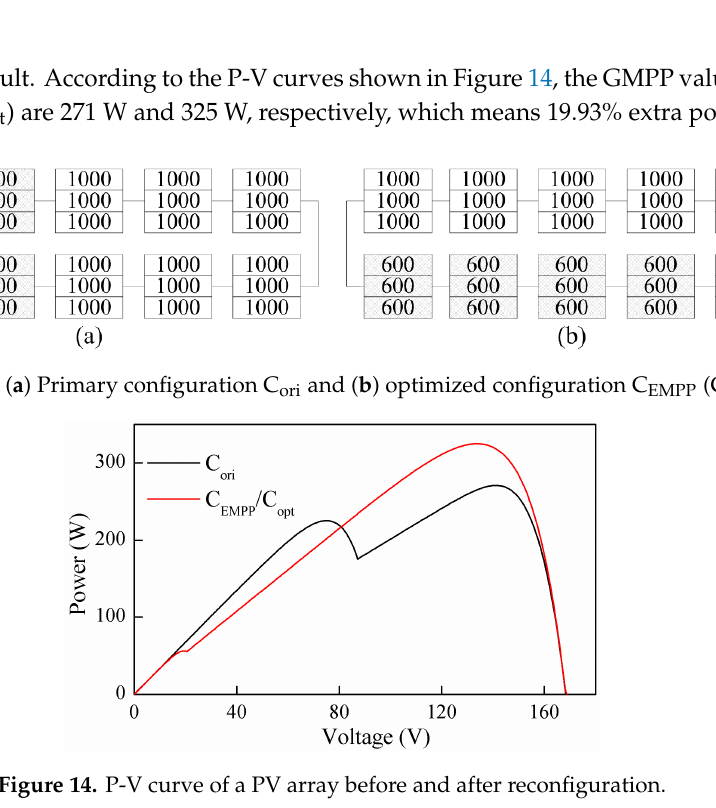
Figure 16. P-V curve of a PV array before and after reconfiguration. 4.4. Case 4 A PV array with three strings was considered in case 4. The irradiance pattern is shown in Figure 17 (a). The temperature of the PV module subjected to 300 W m 2 ⁄